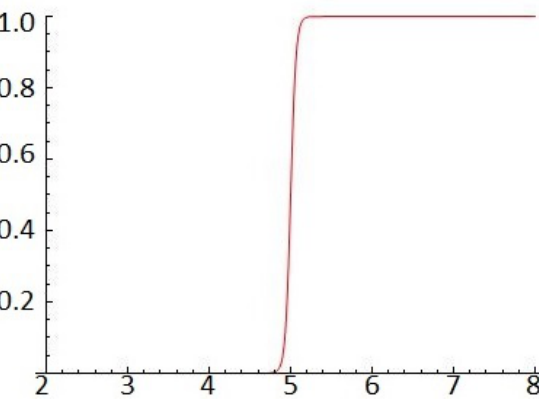
Fig. 1. Approximation of the shifted Heaviside step function by transmuted Stannard growth function for the following data: k = 16 , m = 0 . 52 , β = 0 . 01 , t r = 5 ; Hausdorff distance d = 0 . 0801797 .